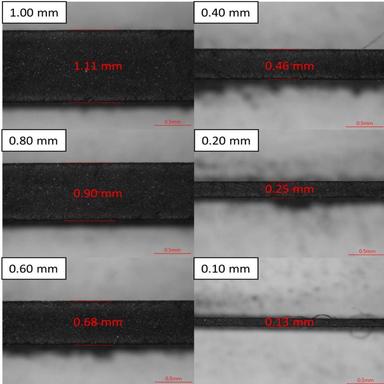
Dimensional characterization of cantilever type structures using optical microscopy (Number within white rectangle represents target dimensions).